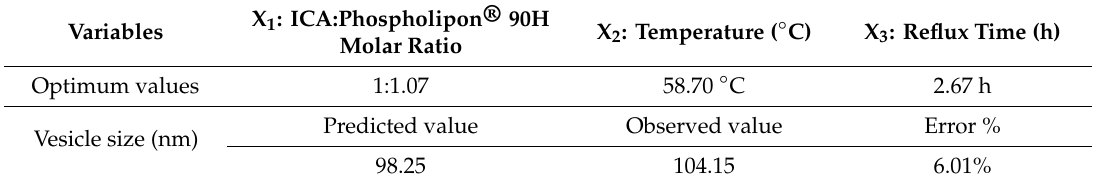
Table 4. Composition of the optimized formulation and its predicted and observed vesicle size.